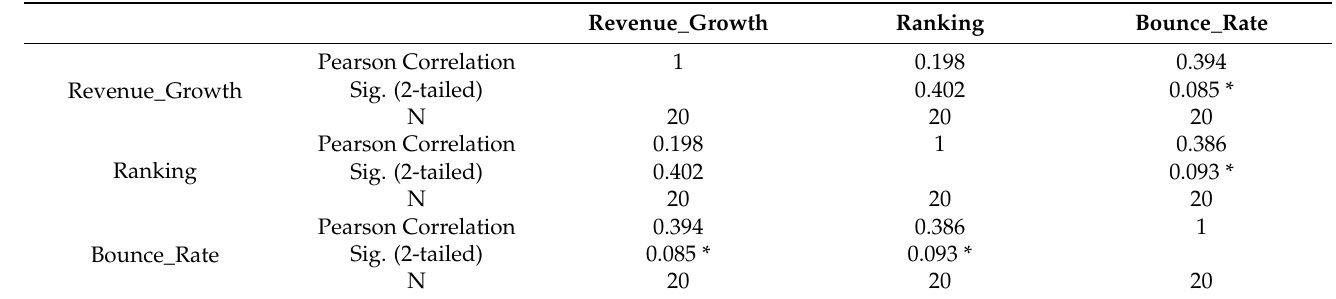
Table 2. Correlations between revenue growth in December 2021 with bounce rate and average visitor duration.